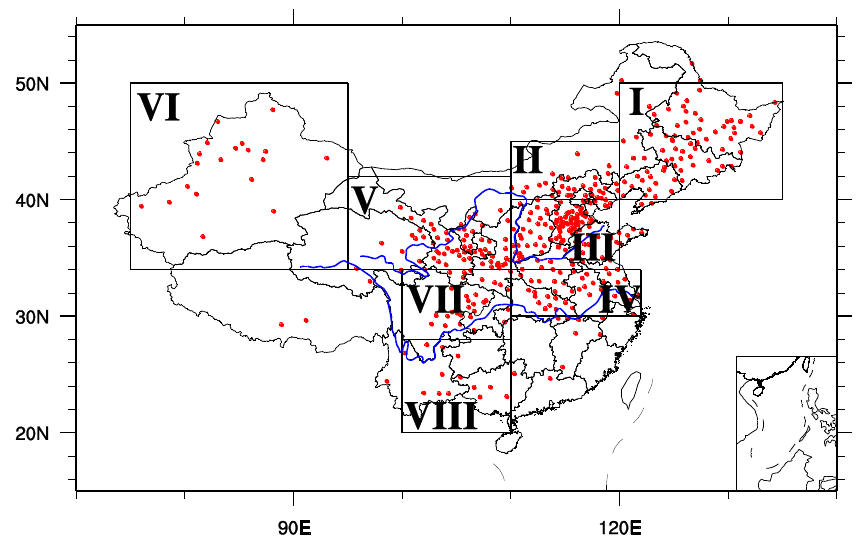
Fig.2. Locations of the 411 in situ soil moisture observation stations (red dots). Also shown (boxes) are the eight subdivisions defined in Table 1 for regional averaging. 688 Table 1. Locations of the eight subregions in